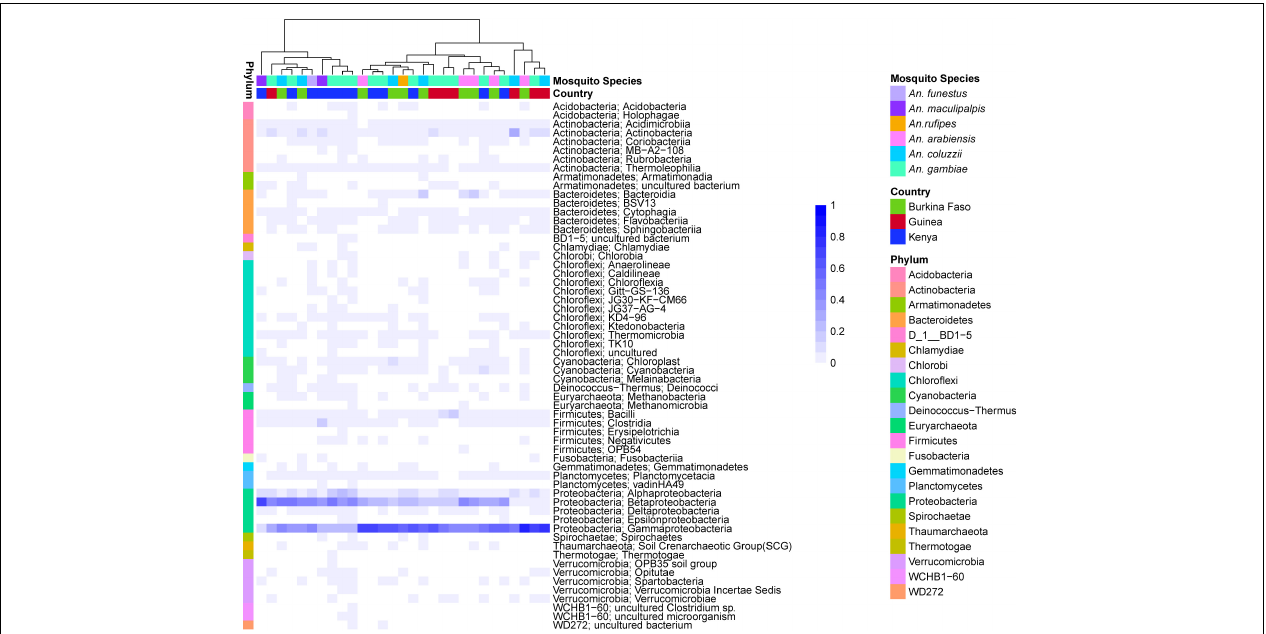
FIGURE 2 | Heatmap depicting the similarity in prokaryotic microbiome composition of field collected larvae shows Betaproteobacteria and Gammaproteobacteria are common members of the prokaryotic microbiome across sampling countries and mosquito species. The heat map is clustered by microbiome similarity and both mosquito species and country of origin are shown above the heatmap for each sample. The dendrogram above the heatmap depicts overall prokaryotic microbiome similarity. The colored vertical bar to the left of the heat map highlight the Phylum membership for identified OTUs with a key to the right of the heatmap. Each column represents a single pool of mosquito larvae subjected to 16S rRNA gene V4 hypervariable region amplicon sequencing. Each row of the heat map indicates the relative proportion of one prokaryotic Class. The shade of blue indicates the proportion of the microbiome occupied by that particular Class level with a key to the right of the